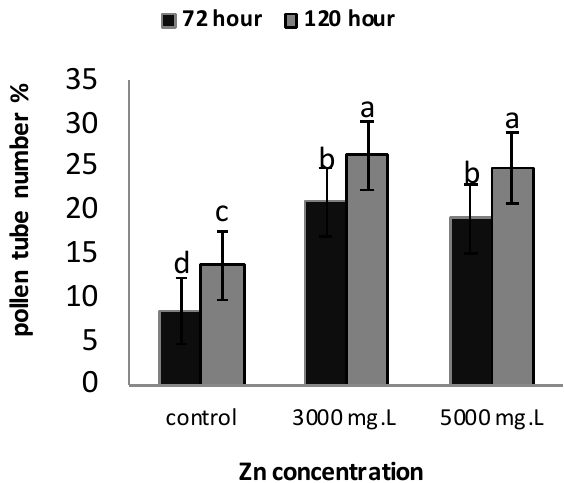
Fig. 9. The interactions between time and Zn concentration on the pollen tube penetration percentage on the beginning of the ovary. Means in each column, followed by similar letter (s) are not signifi- cantly different at 1% probability level.